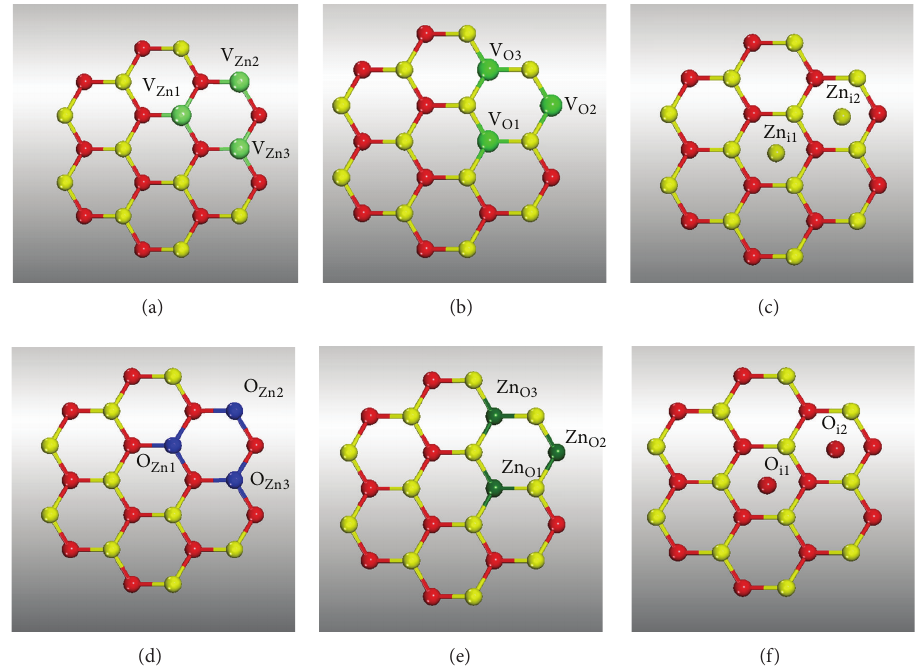
Figure 2: The configurations of ZnO nanowire (a) with V Zn , (b) with V O , (c) with Zn i , (d) with O Zn , (e) with Zn O , and (f) with O i